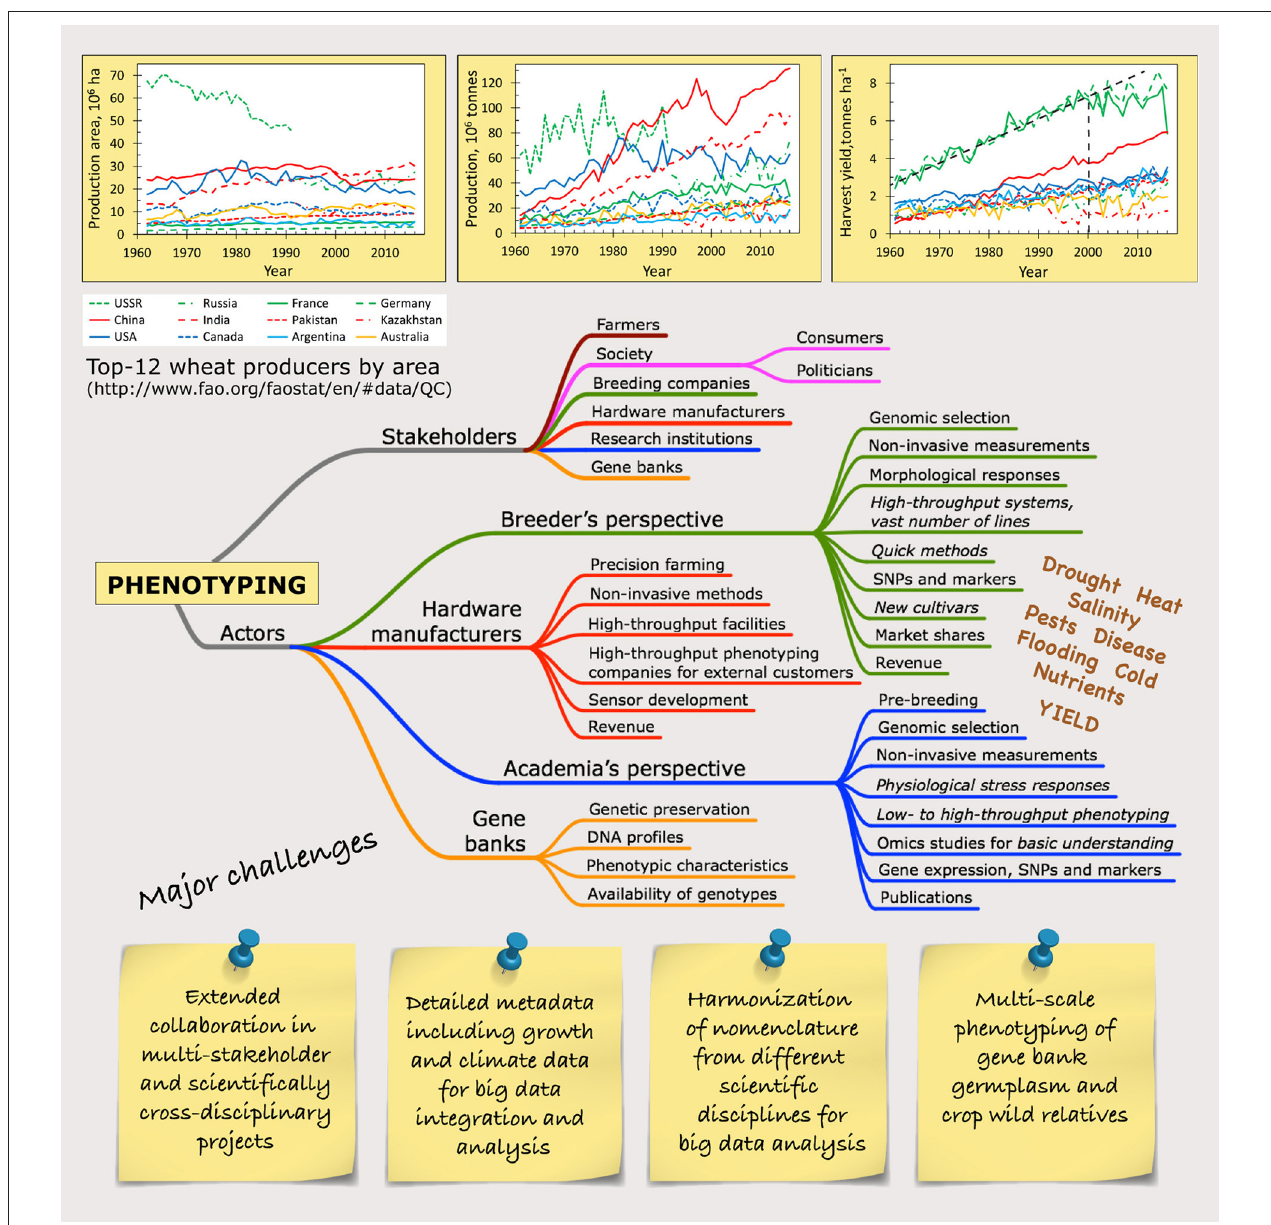
FIGURE 1 | Bulletin board drawing up the current landscape of phenotyping. The development of global crop production, exemplified by the top-12 wheat producers, show that the increase in harvest yield is leveling off since year 2000 in high-yielding areas, while many big producers in terms of area and production already today suffer from environmental limitations as seen in the intermediate to low harvest yields. The mind map of the stakeholders and actors of phenotyping gives a simplified picture of the vast heterogeneity in the phenotyping community, where each focus point can be divided into all different biotic and abiotic stress factors that may be studied. Some major challenges for the years to come are posted. The lines for the top-12 wheat producers are green for Europe (USSR – narrow dashes, Russia – dash/dot, France – solid line, Germany – wide dashes), red for Asia (solid line – China, wide dashes – India, narrow dashes – Pakistan, dash/dot – Kazakhstan), dark blue for North America (solid line – USA, narrow dashes – Canada), light blue for South America (solid line – Argentina) and orange solid line for Australia.